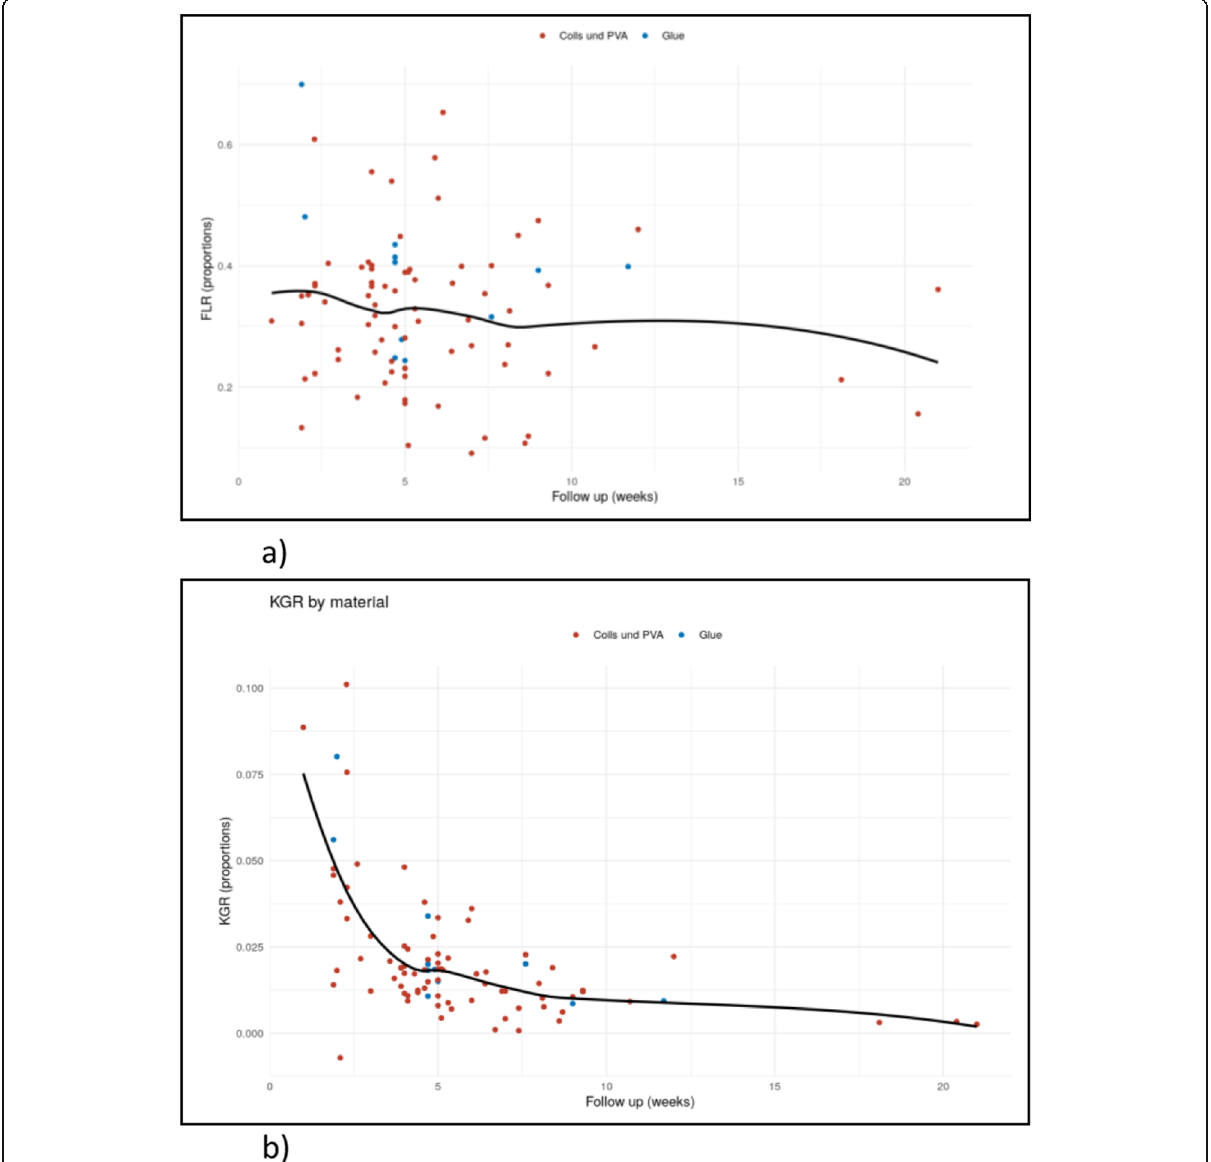
Fig. 1 a , b : In the entire group, the relative growth of FLR using PVA particles and coils was 44% ± 28%; using glue and HVE it was 43% ± 23% and 87% ± 77%, respectively. a : Proportional FLR by methods (coils and PVA versus Glue) and follow up time (weeks). Each point displays the follow up measurement of one patient. The proportional growth of post-intervention sFLR using PVA/coils was 31,9% ±11,9%, and using glue and HVE, was 39,2% ±12,9% and 27,5% ±5,7%, respectively. The black line represents a smoothed local regression curve (across methods). b : Proportional KGR by methods (coils and PVA versus Glue) and follow up time (weeks). Each point displays the follow up measurement of one patient. The KGR using PVA/coils was 2.04% per week ±1.82%, using glue was 2.64% ± 2.24% per week and using HVE was 1.32% ± 1.17% per week. The black line represents a smoothed local regression curve (across